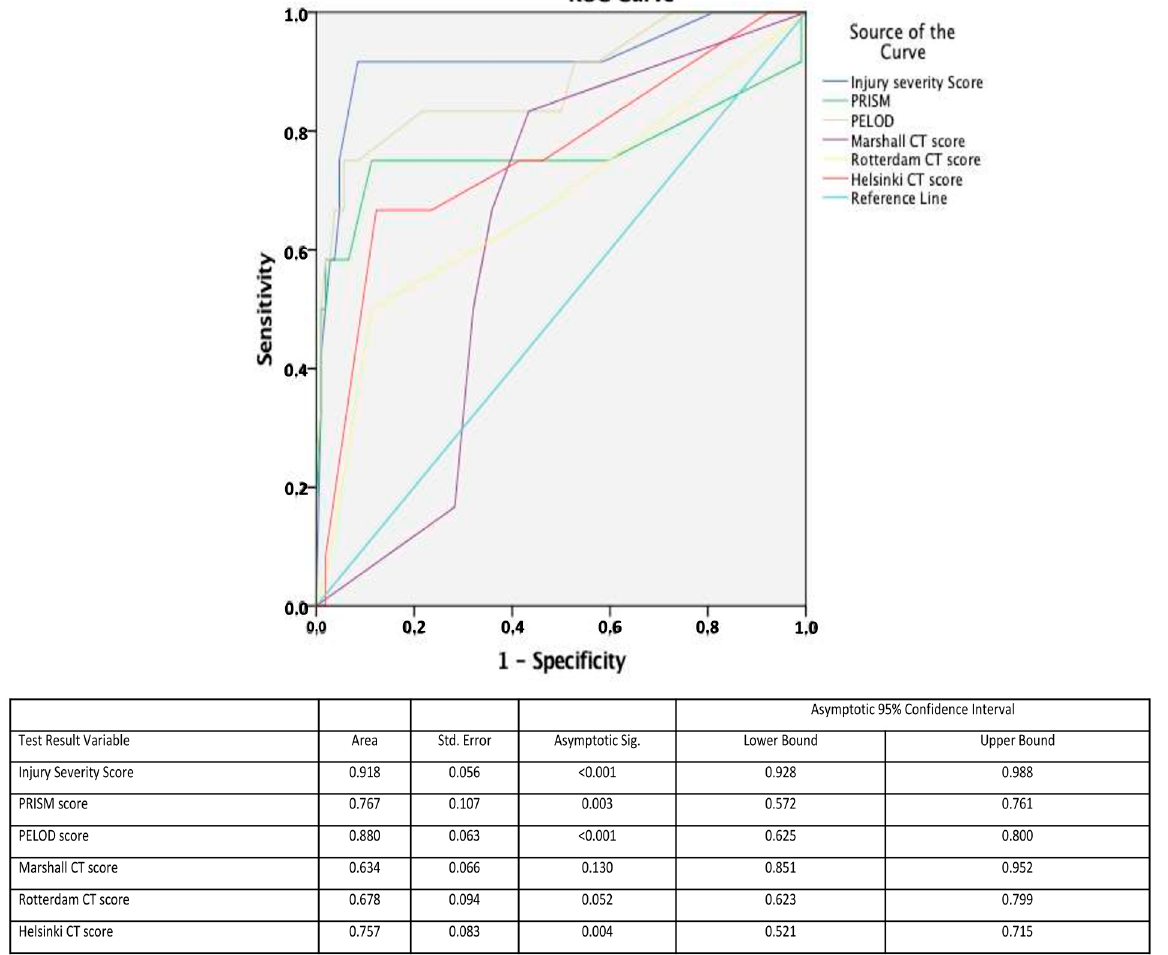
Figure 5. Receiver operator curve (ROC) analysis showing higher area under the curve for ISS and PELOD score. Among the CT scoring systems, the Helsinki CT score displayed the highest perfor- mance.